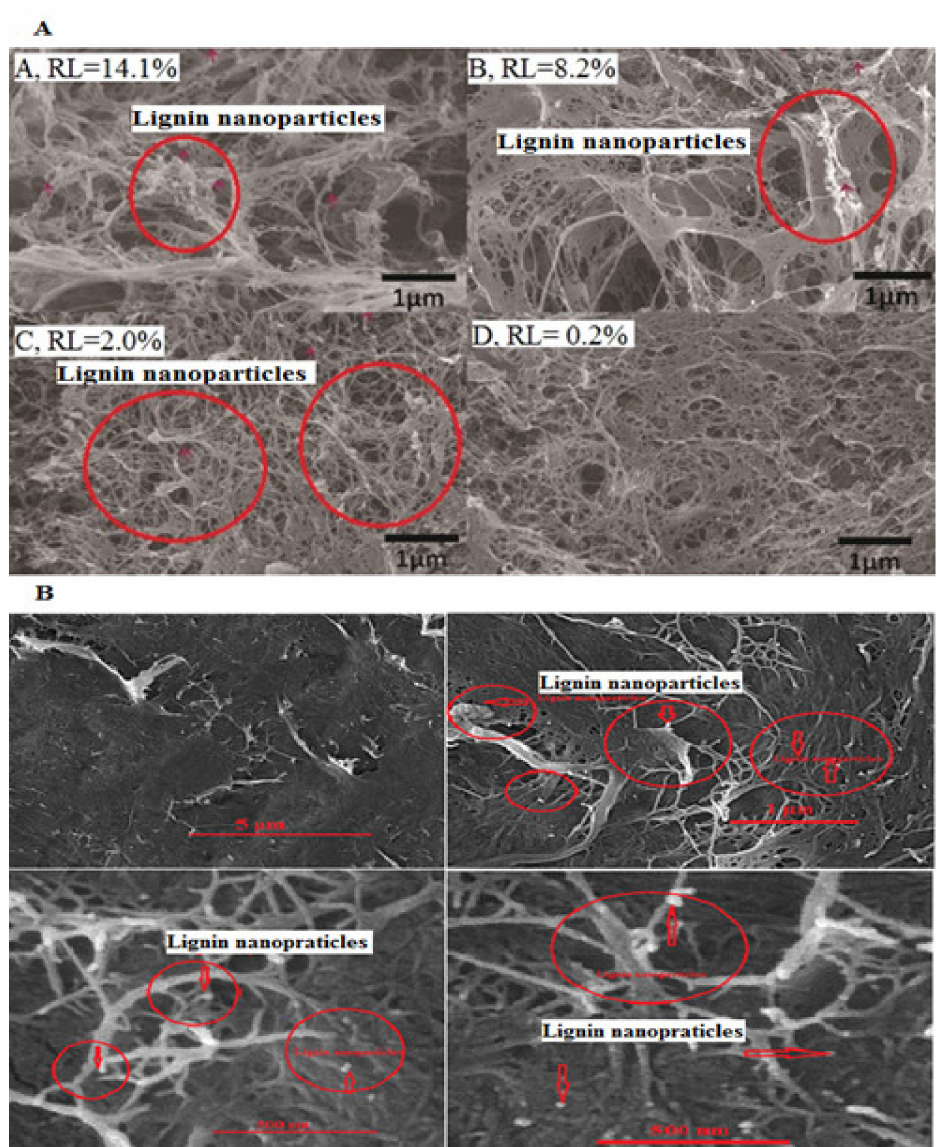
Figure 3. Field emission electron scanning microscopy (FESEM) images of LCNFs ( A ), prepared from poplar with high lignin content (A, RL = 14.01%), medium lignin content (B, RL = 8.2%), low lignin content (C, RL = 2%), and very low lignin content (D, RL = 0.2%) [71]. Permission obtained through Rights Link ® and ( B ) of LCNFs, prepared from chemi-mechanical (CMP) hardwood pulps (unpublished data). The red arrows and red circles indicate lignin nanoparticles